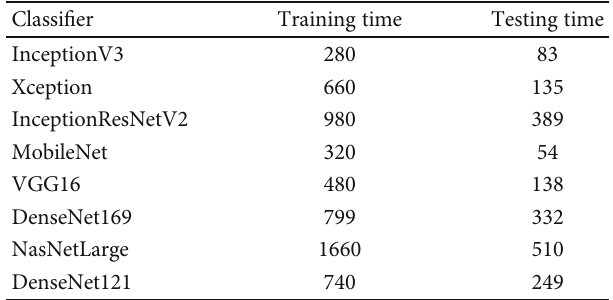
Figure 3: Outline of the method. Table 3: Computational times of all tested CNNs on a GPU